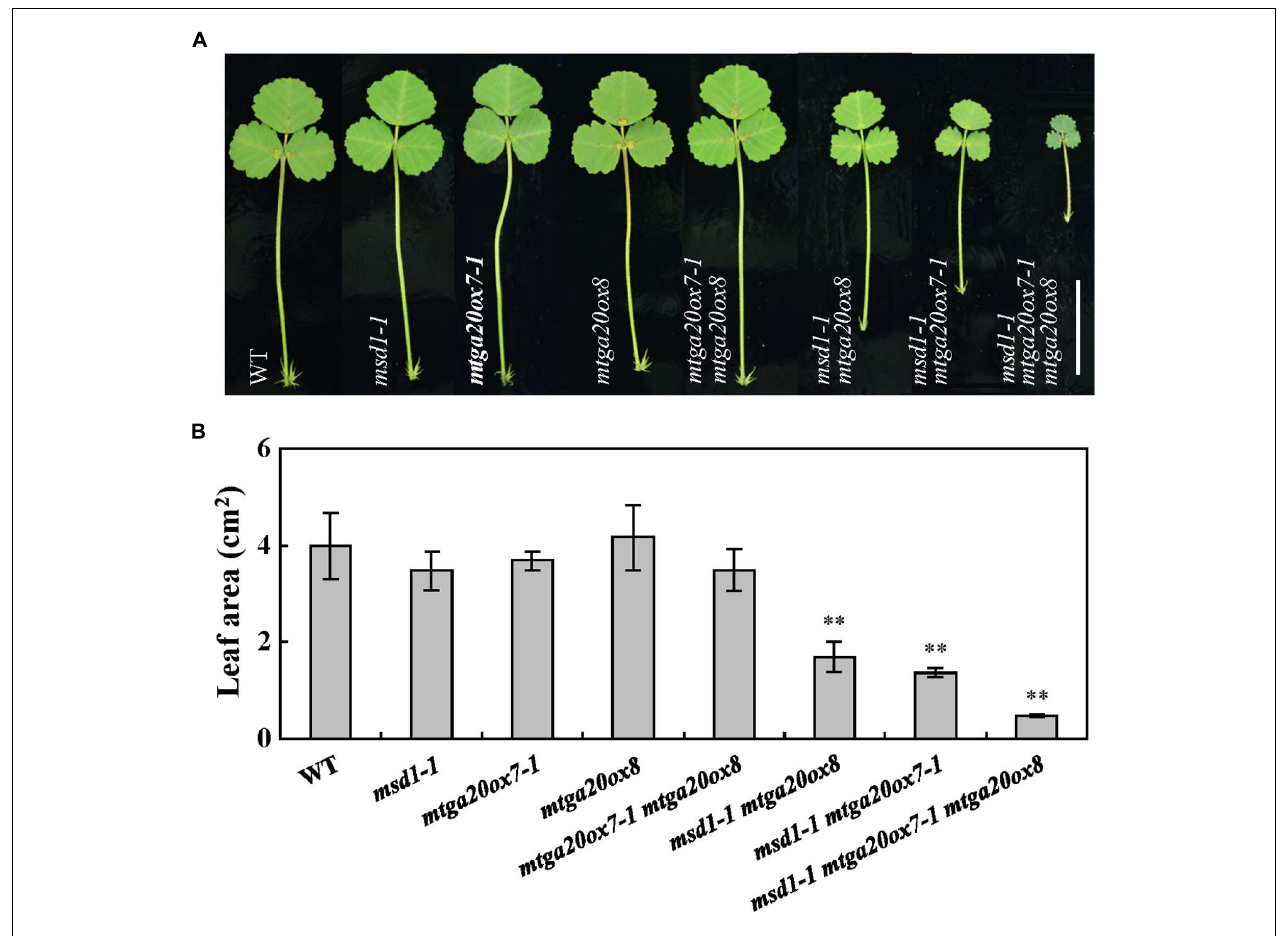
FIGURE 6 | Comparison of leaves in wild type and mtga20ox mutants. (A) Phenotype of leaves in 4-week-old wild type (WT) and diverse mtga20ox mutants. Bars = 2 cm. (B) Comparison of leaf size in WT and mtga20ox mutants. Bars represent means ± SD ( n = 16); asterisks indicate significant differences from the WT ( ∗∗ P < 0.01, Student’s t-